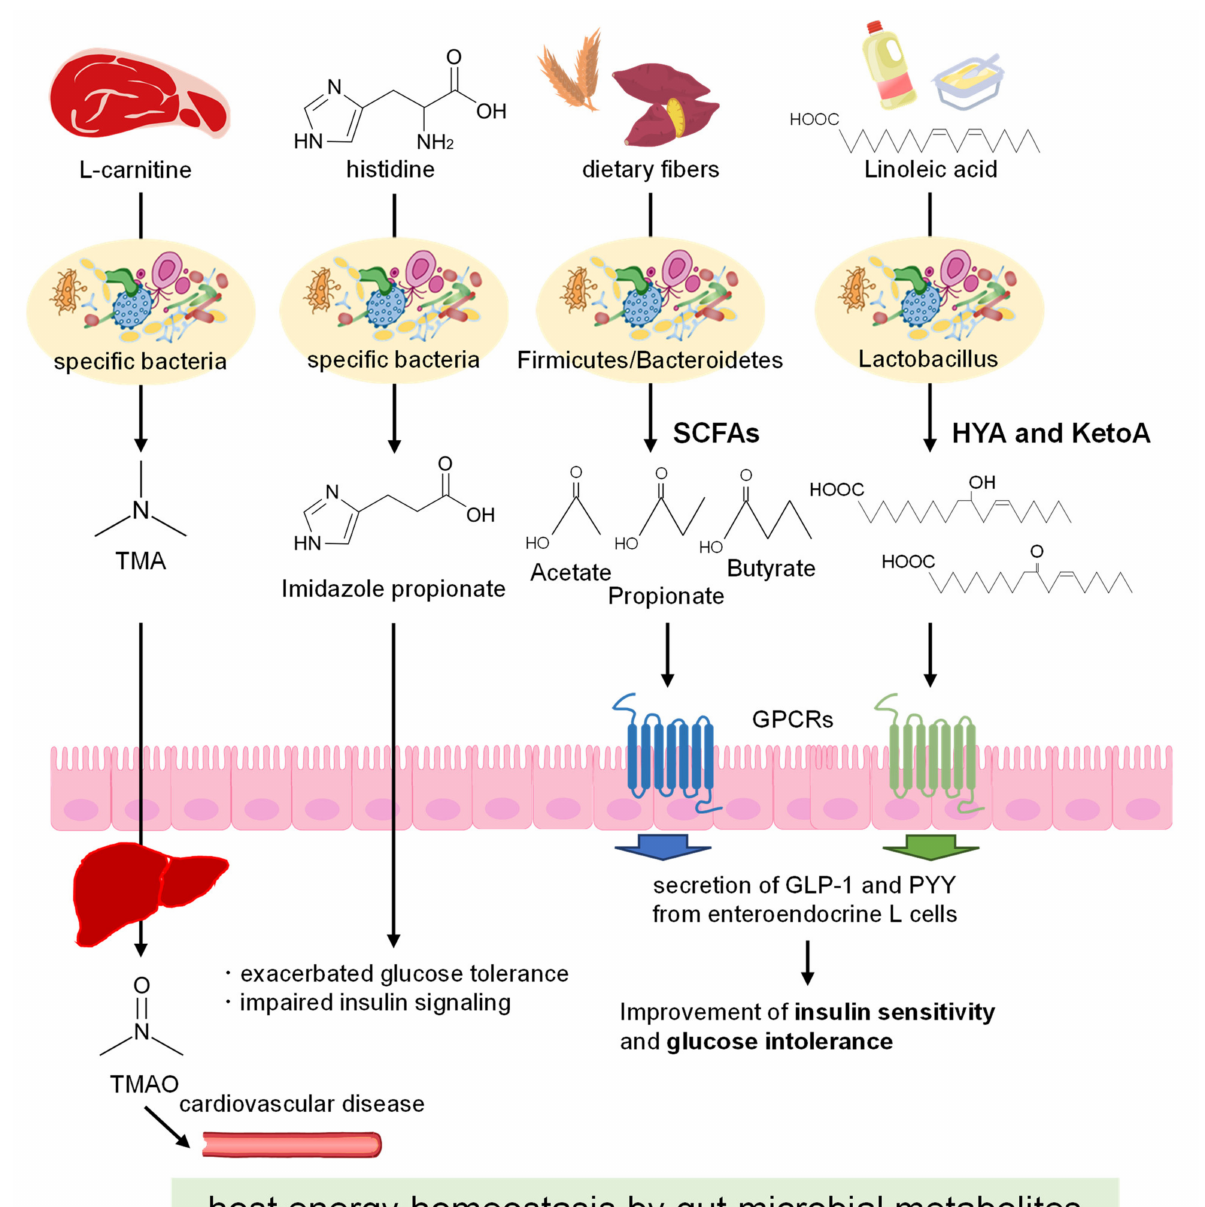
Figure 1. The diet-derived microbial metabolites in the host energy